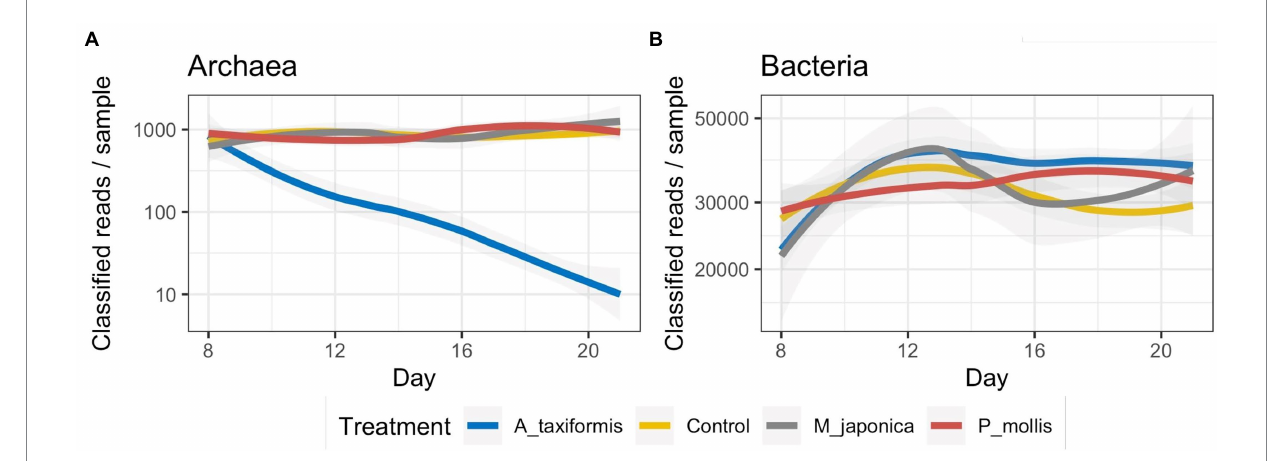
FIGURE 1 Number of reads denoised into (A) archaeal and (B) bacterial ASVs. Archaeal data is presented on a logarithmic scale for